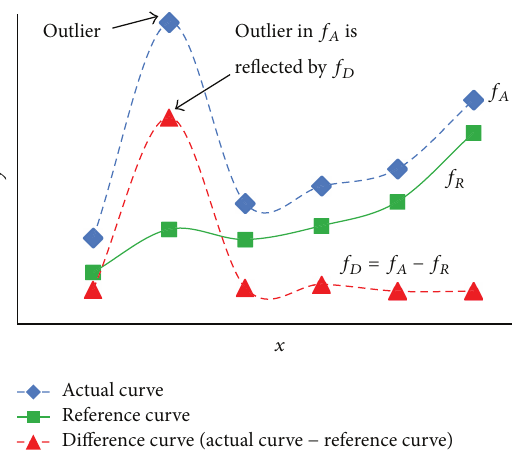
Figure 2: If 𝑓 𝐴 represents the curve of actual data and if it is possible to find a curve 𝑓 𝐷 = 𝑓 𝐴 − 𝑓 𝑅 ≈ 𝑐 where 𝑓 𝑅 is a reference curve that represents actual behaviour of the real data, 𝑓 𝐷 reflects the existing outliers of 𝑓 𝐴 . When there are no outliers, difference curve (𝑓 𝐷 ) is always nearly a constant.